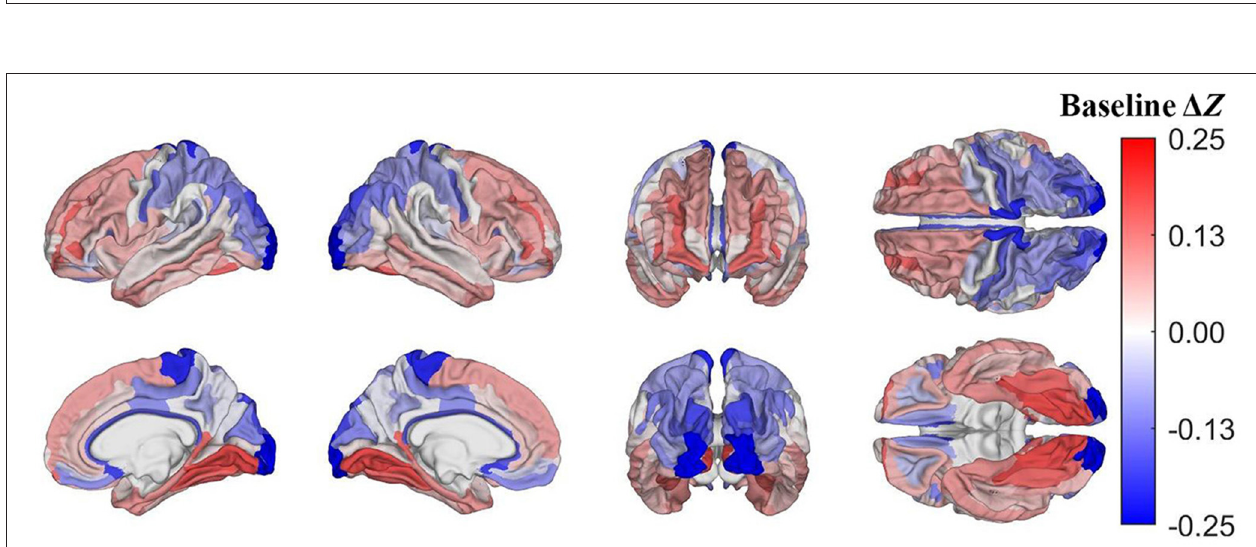
FIGURE 3 | Cortical map of subject-averaged R in HCs at baseline. For visual comparison, the color scheme resembles that of Glasser et al. and R values were computed at the vertex level.